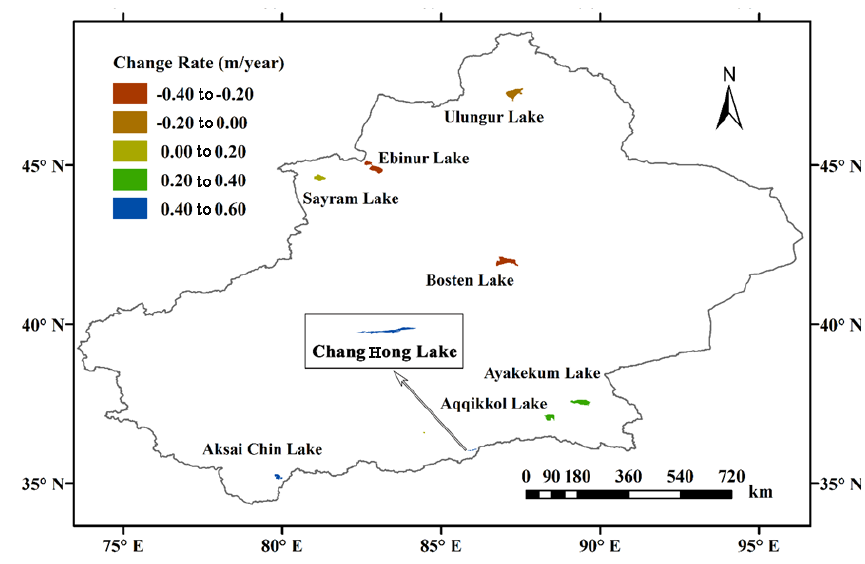
Figure 4. Water level change rate of eight typical lakes from 2003 to 2009.